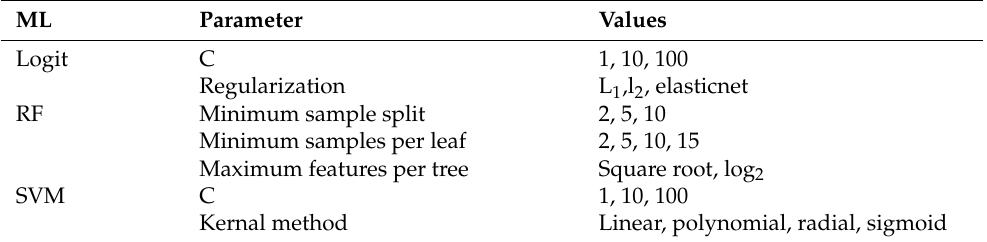
Table A1. Tuned parameters for the machine learning (ML) models.